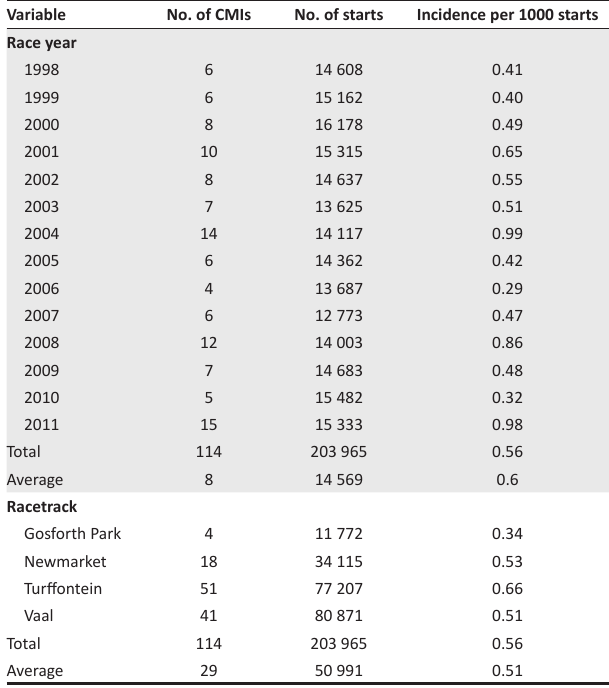
TABLE 1: Incidence of catastrophic musculoskeletal injuries per racing year and racetrack.